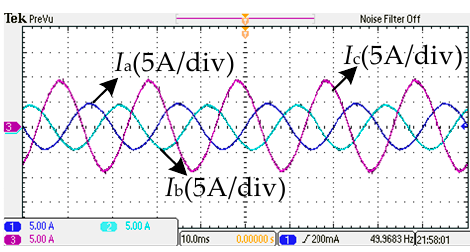
Figure 23. Three-phase current with no DC voltage Figure 23. Three ‐ phase current with no DC voltage ripples.